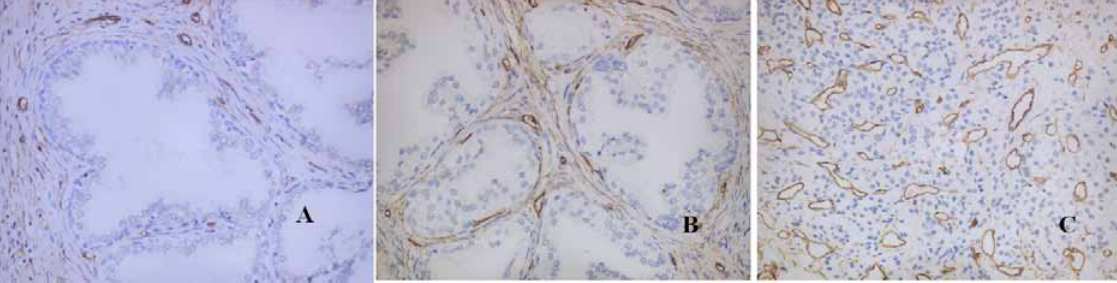
Figure 4. In CEACAM5 expression areas, LVD shows significant difference in BPH(A), PIN(B) and PCa(C). 400×